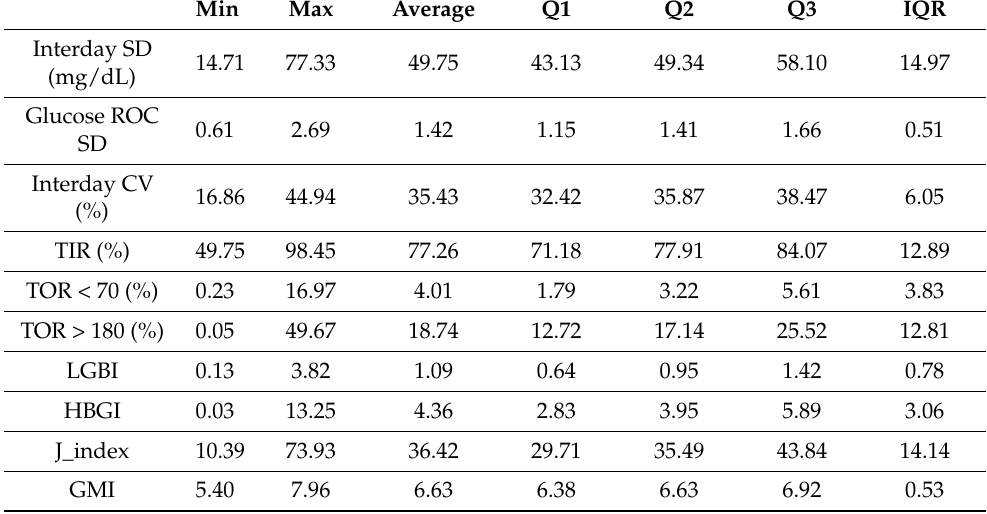
Table 3. Summarised statistics for glucose variability. Total number of individuals ( n ) =